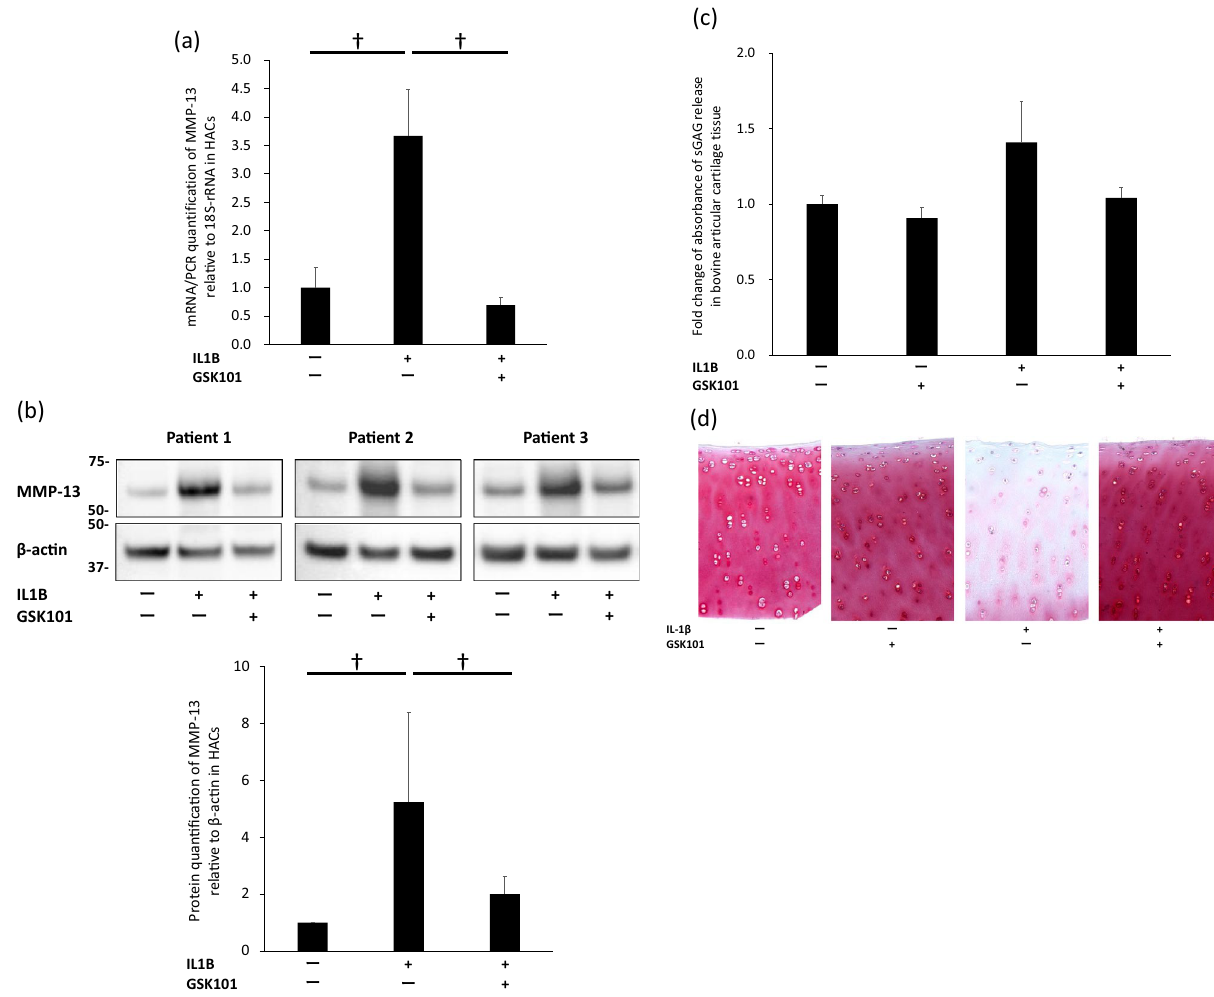
Figure 2. Reduction of IL-1β-induced cartilage damage by GSK101. ( a ) Real-time PCR of HAC lysates to examine the expression of MMP-13 after 12 h of treatment with 1000 pM GSK101, and ( b ) Western blot analysis of HAC lysates to examine the expression of MMP-13 after 48 h of treatment with 1000 pM GSK101. Experiments were repeated three times. Each group of the membrane associated with MMP-13 and the membrane associated with β-actin were different while their protein samples were the same. ( a ), ( b ) showed that GSK101 significantly reduced the expression of MMP-13 induced by IL-1β stimulation in HACs. Next, we performed DMMB assay on day 3 of explant culture and Safranin O/Fast Green staining on day 7 of explant culture of bovine articular cartilage tissue. Three replicates were used in each group. ( c ) In the DMMB assay, stimulating tissues with IL-1β significantly increased the elution of sGAG into the medium compared to the untreated control, while co-treatment with GSK101 significantly suppressed the IL-1β-induced release of sGAG. ( d ) In Safranin O/Fast Green staining of tissues after 7 days of IL-1β stimulation, similar tendency among three replicates was observed that substantial amounts of proteoglycans were lost from the explants and that these effects were almost completely rescued by co-treatment with GSK101. † p < 0.05 using one-way ANOVA with Tukey’s test. DMMB: dimethylmethylene blue; HAC: human articular cell; sGAG: sulfated